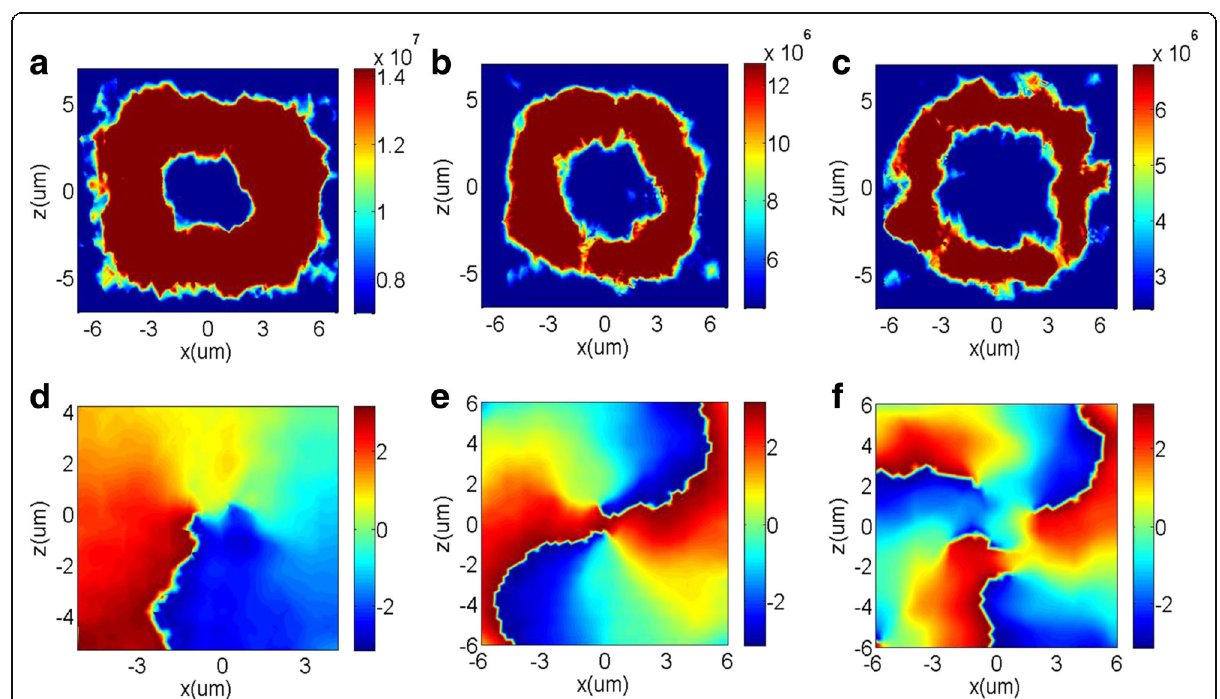
Fig. 6 a – c The transmitted intensity distributions and d – f the phase wavefronts of the generated vortex beams at z = 10 μ m with topological charge of l = 1 , 2 , 3 based on the metasurfaces M 1 , M 2 , and M 3 under the X-polarized incidence,